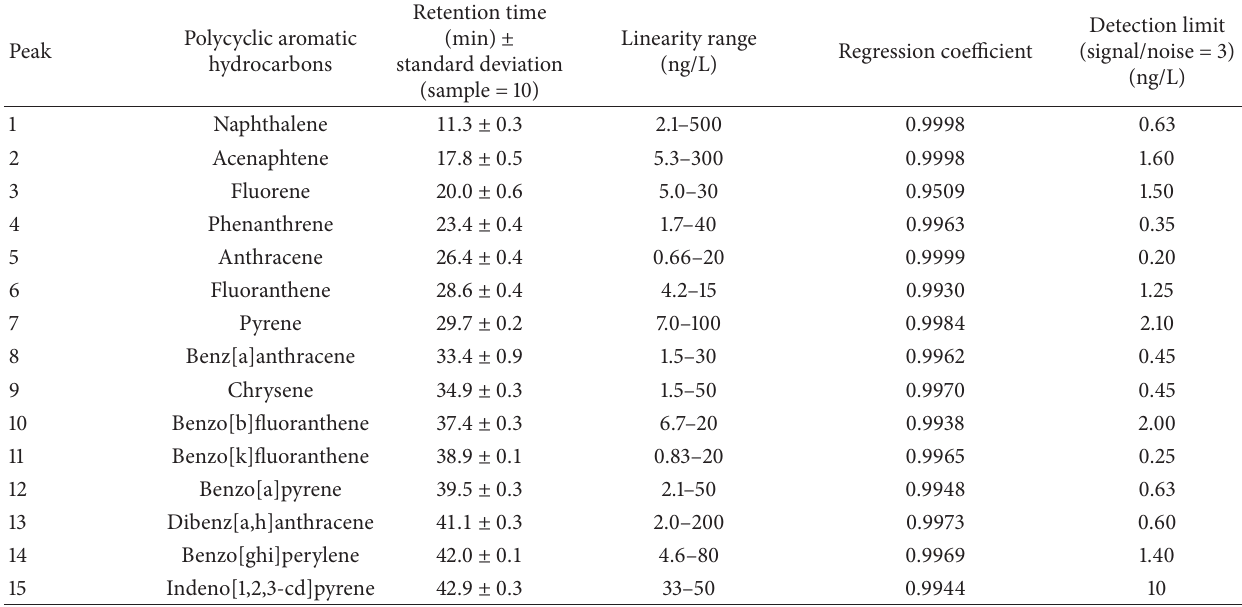
Table 1: Analytical characteristics of chromatographic method.